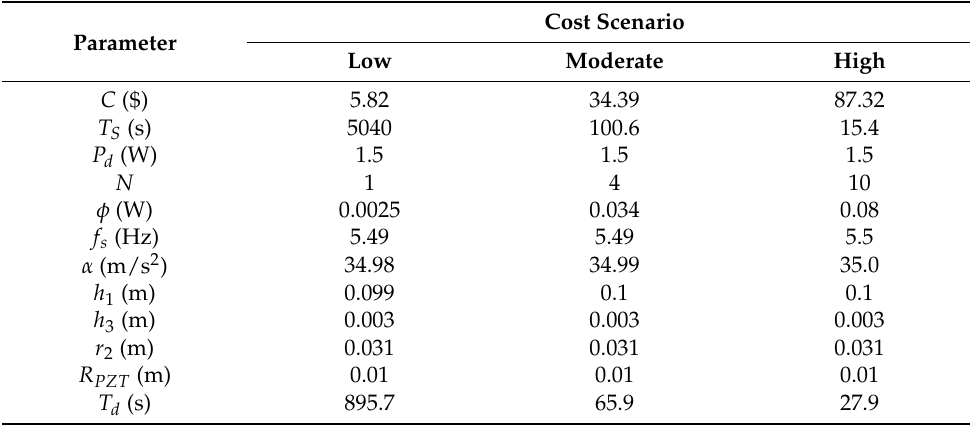
Figure 7. Multi-objective GA optimization for the shake duration and the cost. Table 6. Optimal System Parameters for Three Cost Scenarios.